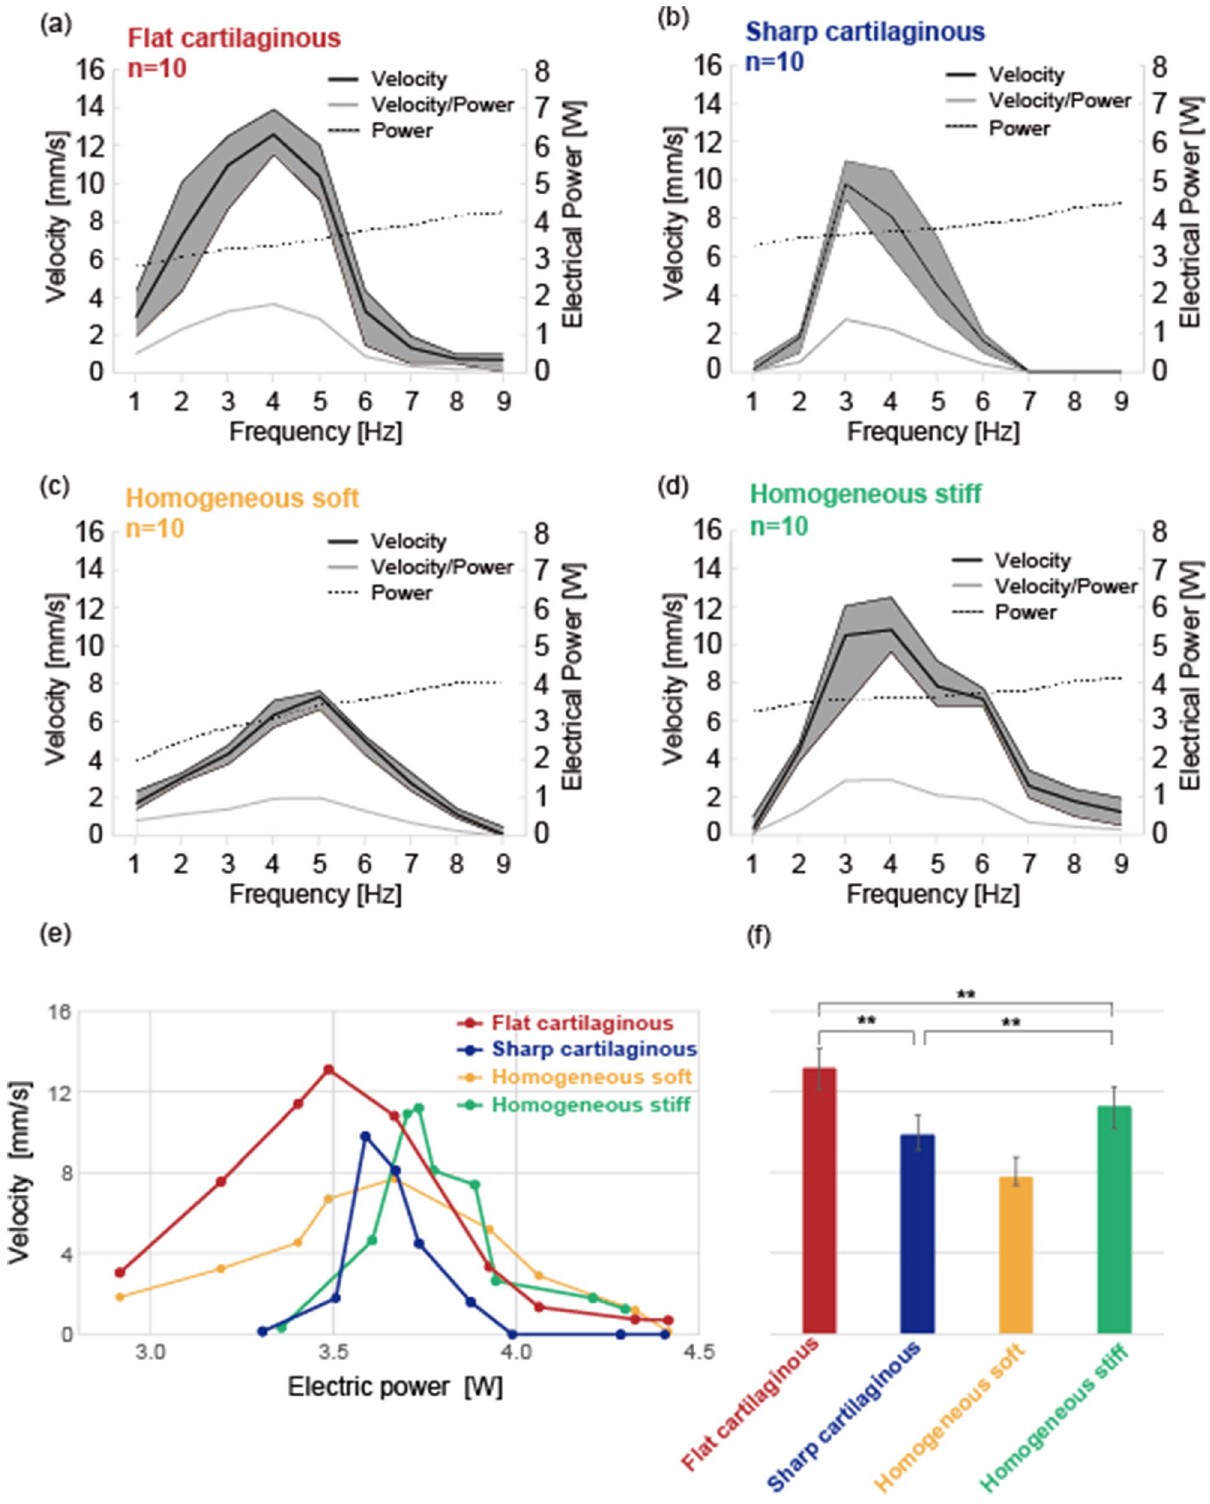
Figure 8. Measured swimming speed and electric power consumption as functions of the driving frequency for: ( a ) robot with flat cartilaginous, ( b ) robot with sharp cartilaginous, ( c ) robot made of homogeneous soft material, and ( d ) robot with homogeneous stiffness made of a mixture of soft tissue and cartilage materials. ( e ) Swimming speed as a function of the electric power. ( f ) Summary of the peak velocities at the optimal frequencies following Figs. ( a – d ). Significant differences in the average velocity according to ANOVA test are (p < 7.5e10 −8 ) between the flat and sharp cartilaginous, (p < 4.9e10 −4 ) between the flat cartilaginous and the homogeneous stiff cartilaginous, and (p < 2.5e10 −3 ) between the sharp and the homogeneous stiff cartilaginous. The robot with flat cartilage structure exhibits the highest speed and the lowest power consumption indicating the effect cartilage structure inclusion on the swimming